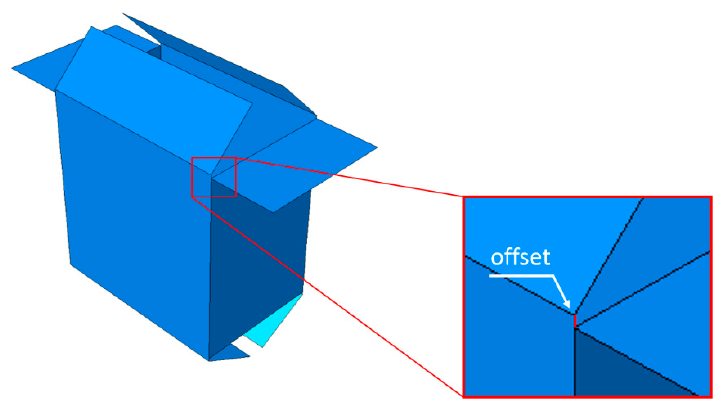
Figure 1. Box with offset flaps.